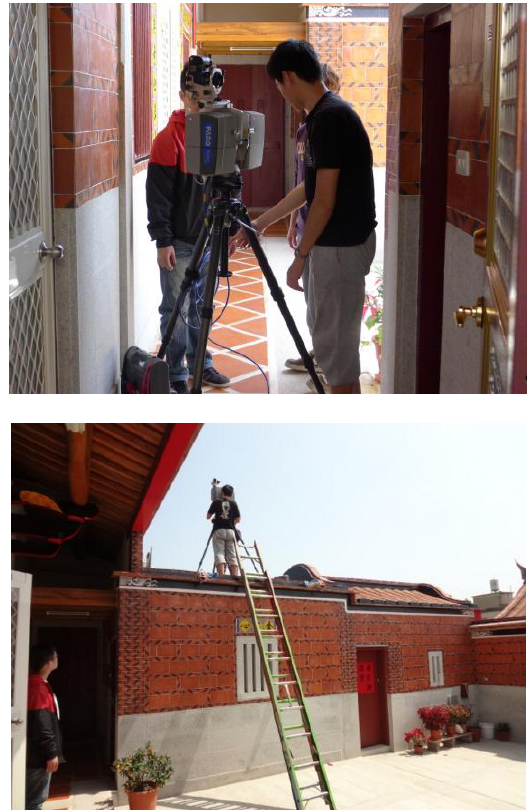
Figure 3. FARO Photon 120 3D laser scanner